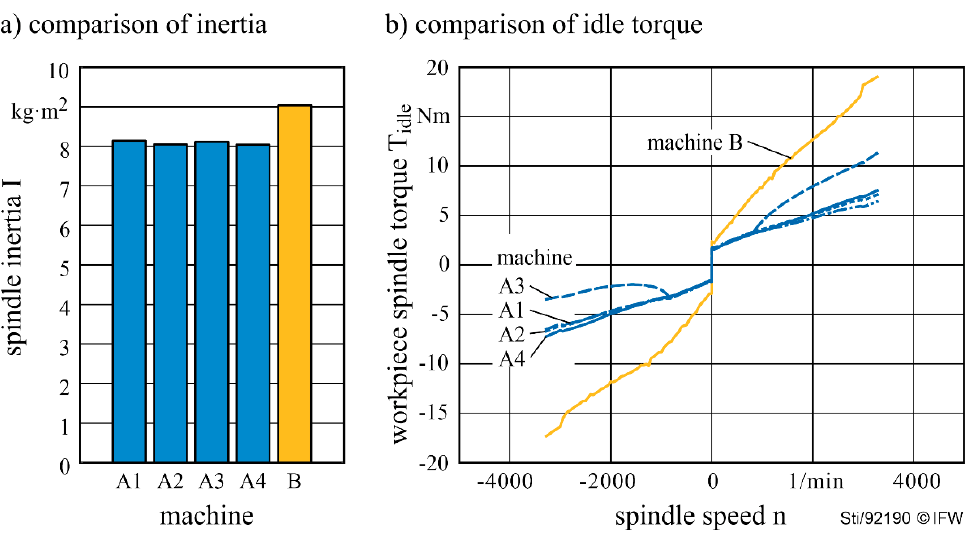
Figure 4. Comparison of parameters used to compensate ( a ) inertia and ( b ) idle torque on lathes.